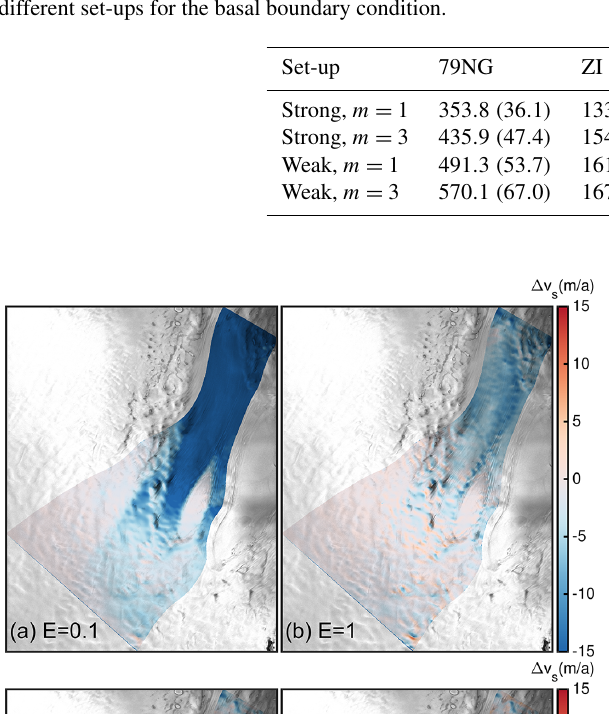
BP-like model results in higher discharge than FS, whereas the differences show a different magnitude: at 79NG, BP-like ice discharge is up to 40 % ( m = 1) and 50 % ( m = 3) higher than FS. In contrast, a moderate difference of about 5 % in both friction laws is found for